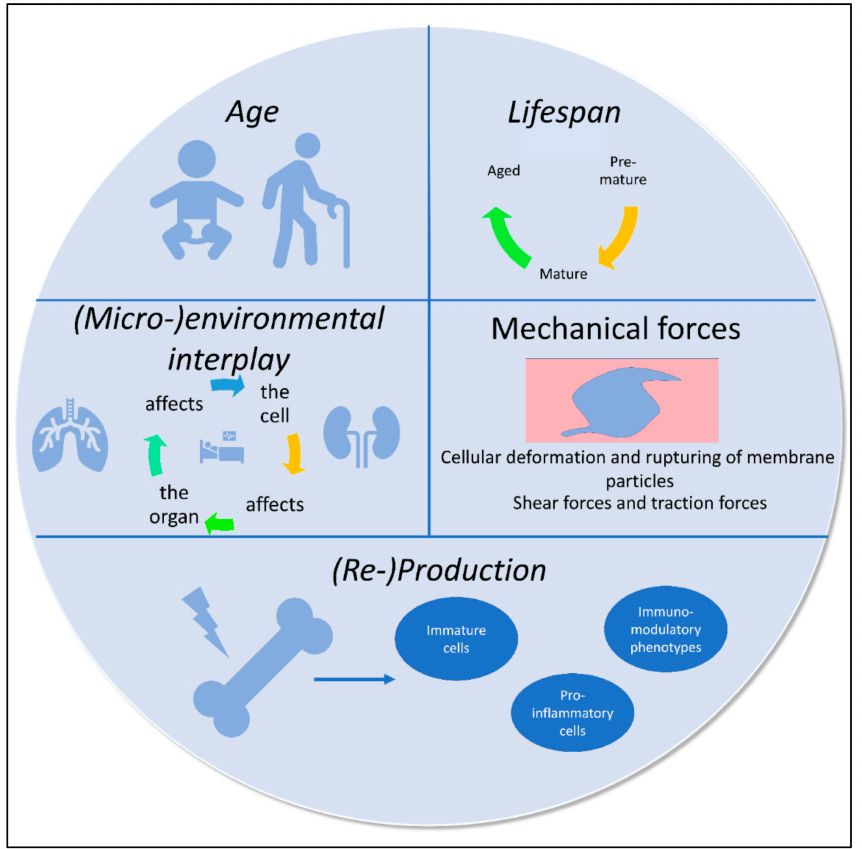
Figure 2. Example of generalizable principles of immune cell phenotype changes. Age, lifespan and microenvironments are known to impact occurrence and regulation of immune cell phenotypes. Additionally, mechanical forces, leading to deformation and disruption of membrane components, can lead to changes in shape, membrane composition, activation patterns and overall phenotype appearance. Demand-dependent (re-)production leads to occurrence of various distinct phenotypes, including immature, pro-inflammatory and immunomodulatory cellular